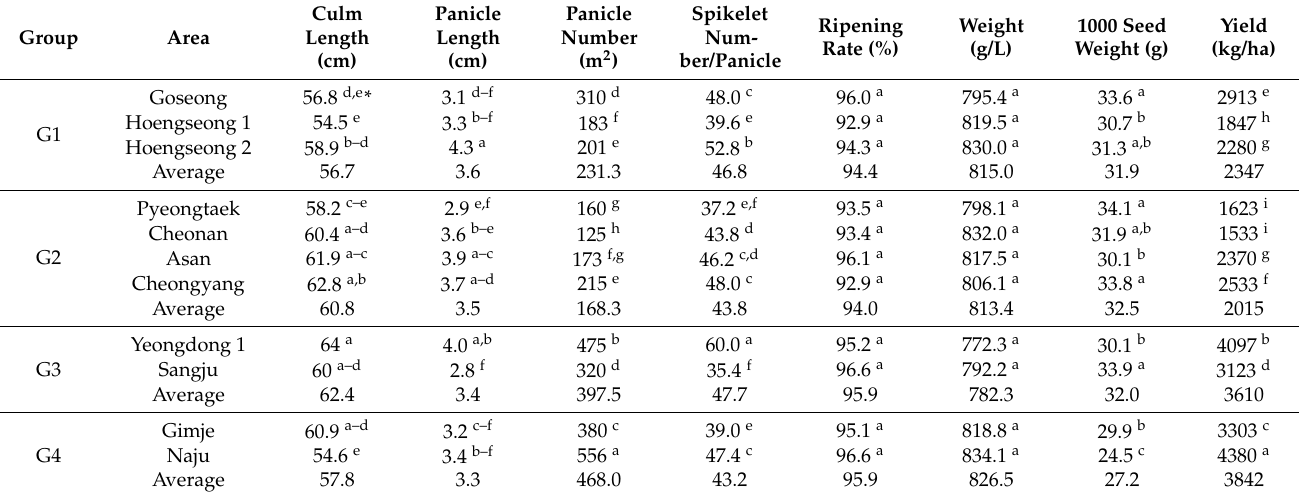
Table 5. Yield components and yield of dehulled barley plants in different group areas at harvest in